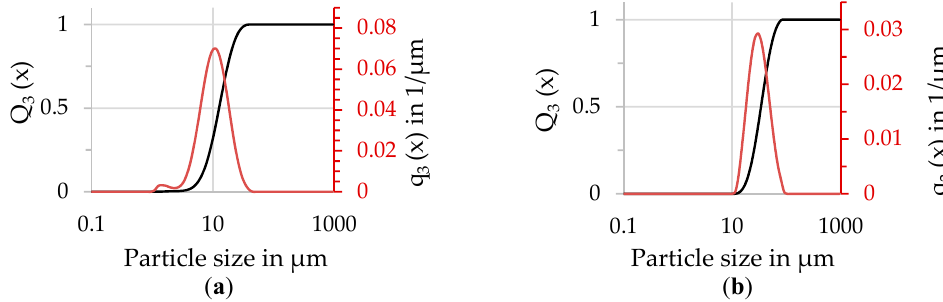
Figure 6. Particle size distribution of ( a ) fine fraction ( b ) coarse fraction. Q 3 = volume cumulative distribution, q 3 = volume density distribution.